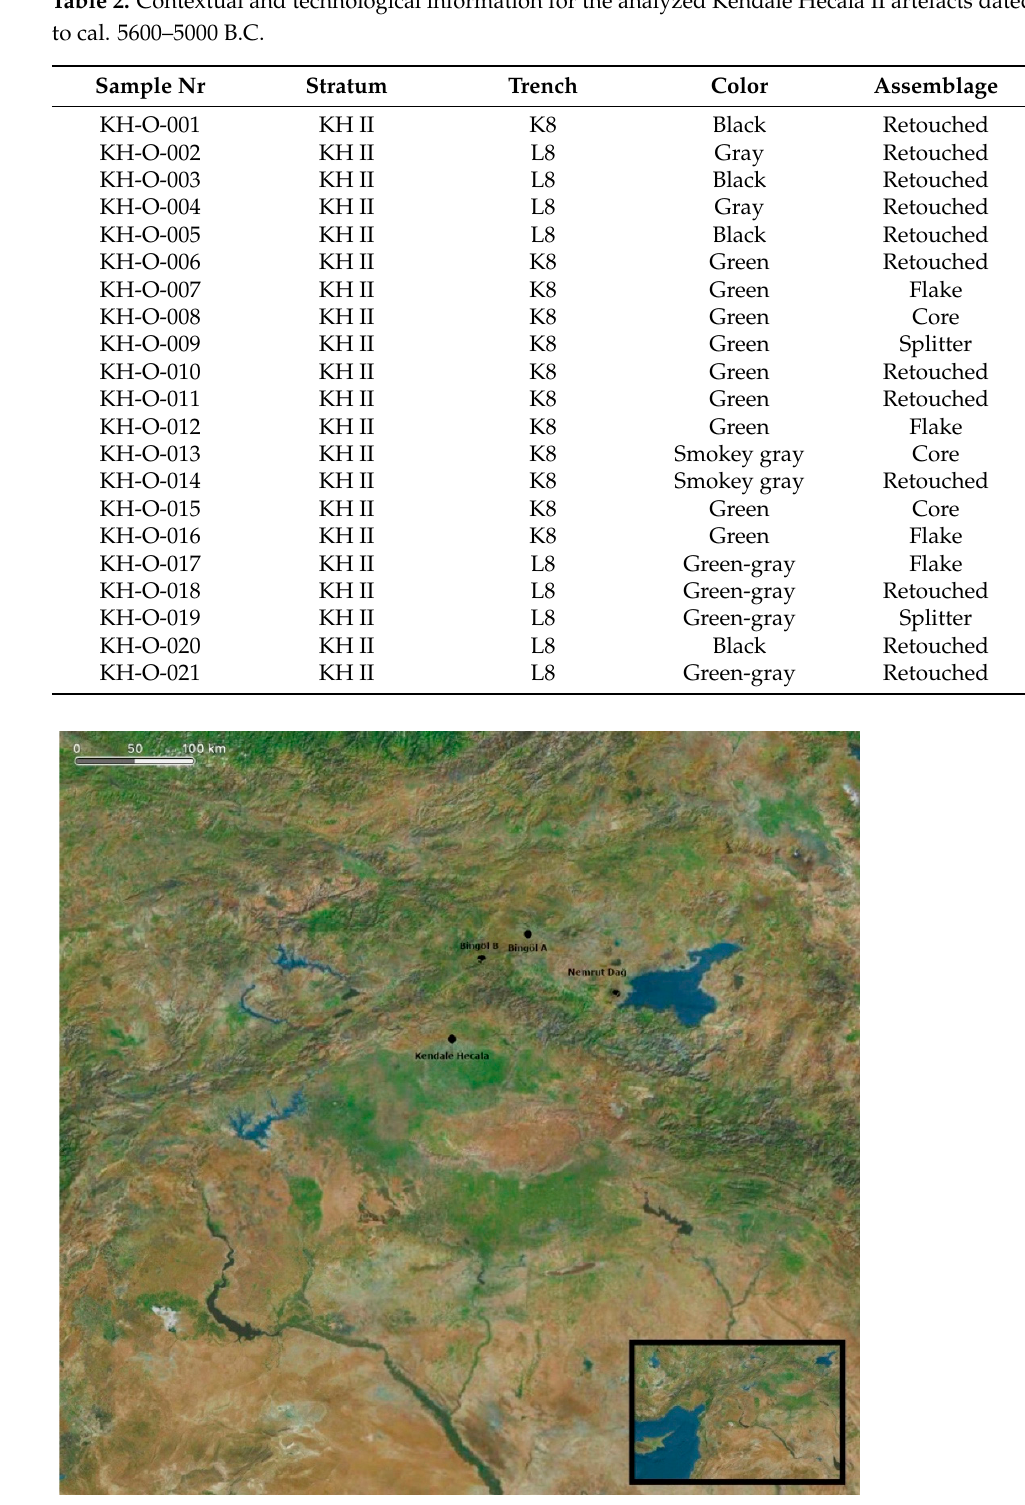
Figure 6. Map showing the locations of Kendale Hecala and obsidian sources at Bingöl A, Bingöl B and Nemrut Da ğ (Google Earth image).